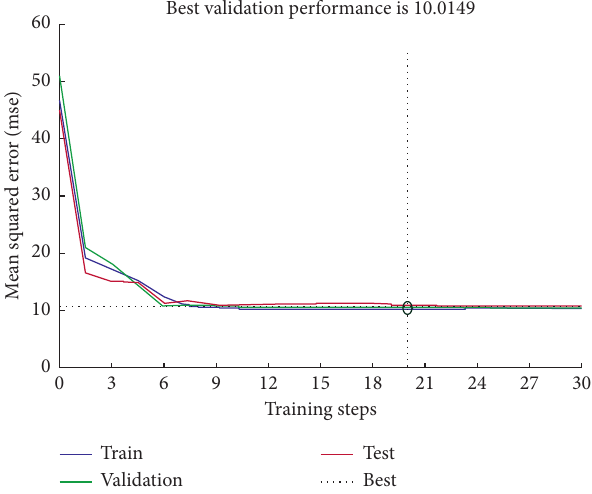
Figure 12: The training and validation of Im-ELM. Table 5: The comparison between Im-ELM and other models.